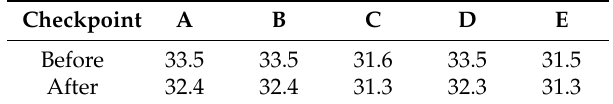
Table 3. Historical center of Ascoli Piceno—Temperature ( ◦ C) before and after. Checkpoint A B E Before